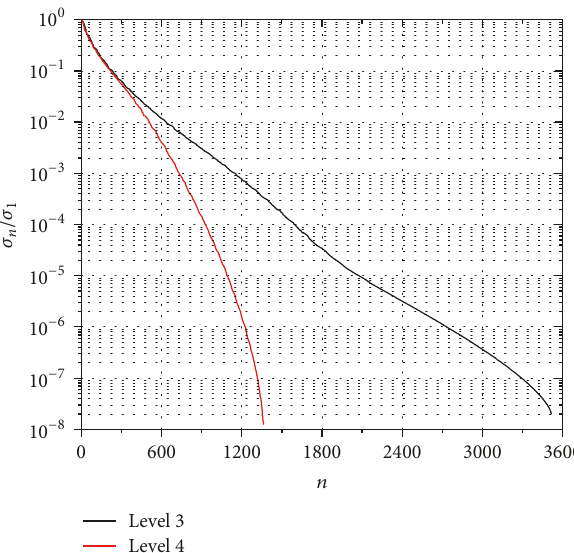
Figure 1: Normalized singular values of the aggregation matrix.